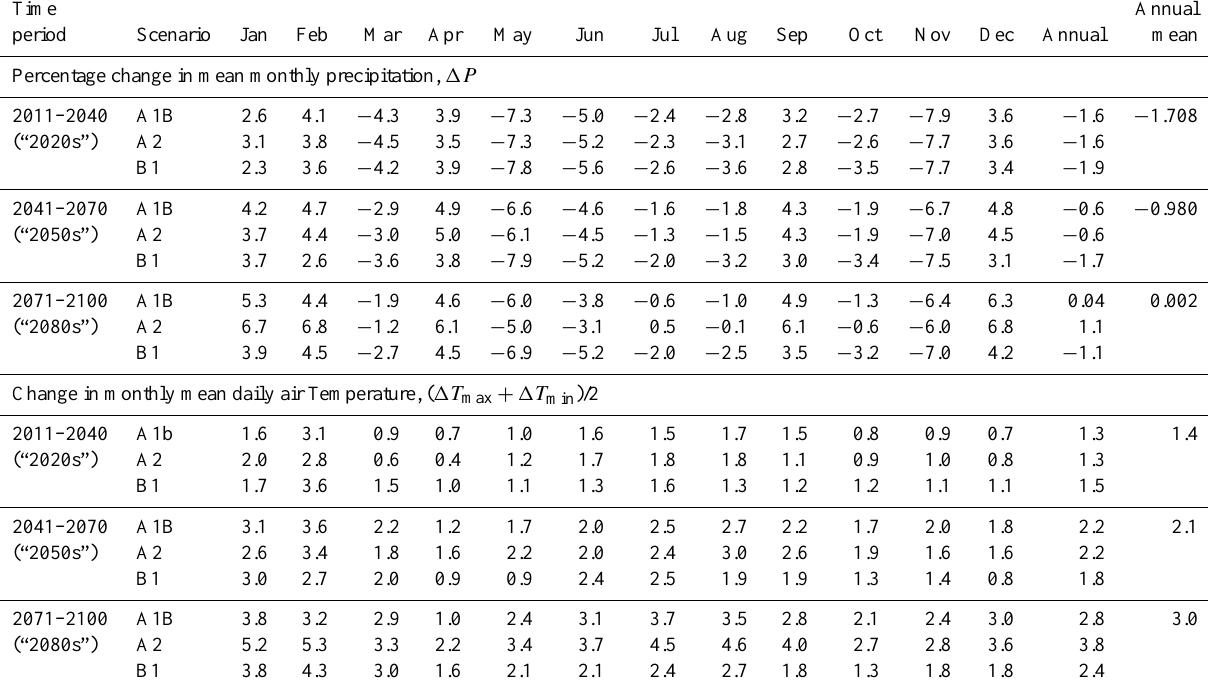
Table 1. Relative changes in watershed averaged monthly GCM projections of precipitation and air temperature in comparison to reference periods’ climates for A1B, A2 and B1 scenario for 2020s, 2050s, and 2080s time periods. Annual is the relative changes in mean annual climate (precipitation and temperature) in future projections in relation to the reference periods’ climates. Annual mean is the mean of three annuals for the A1B, A2 and B1